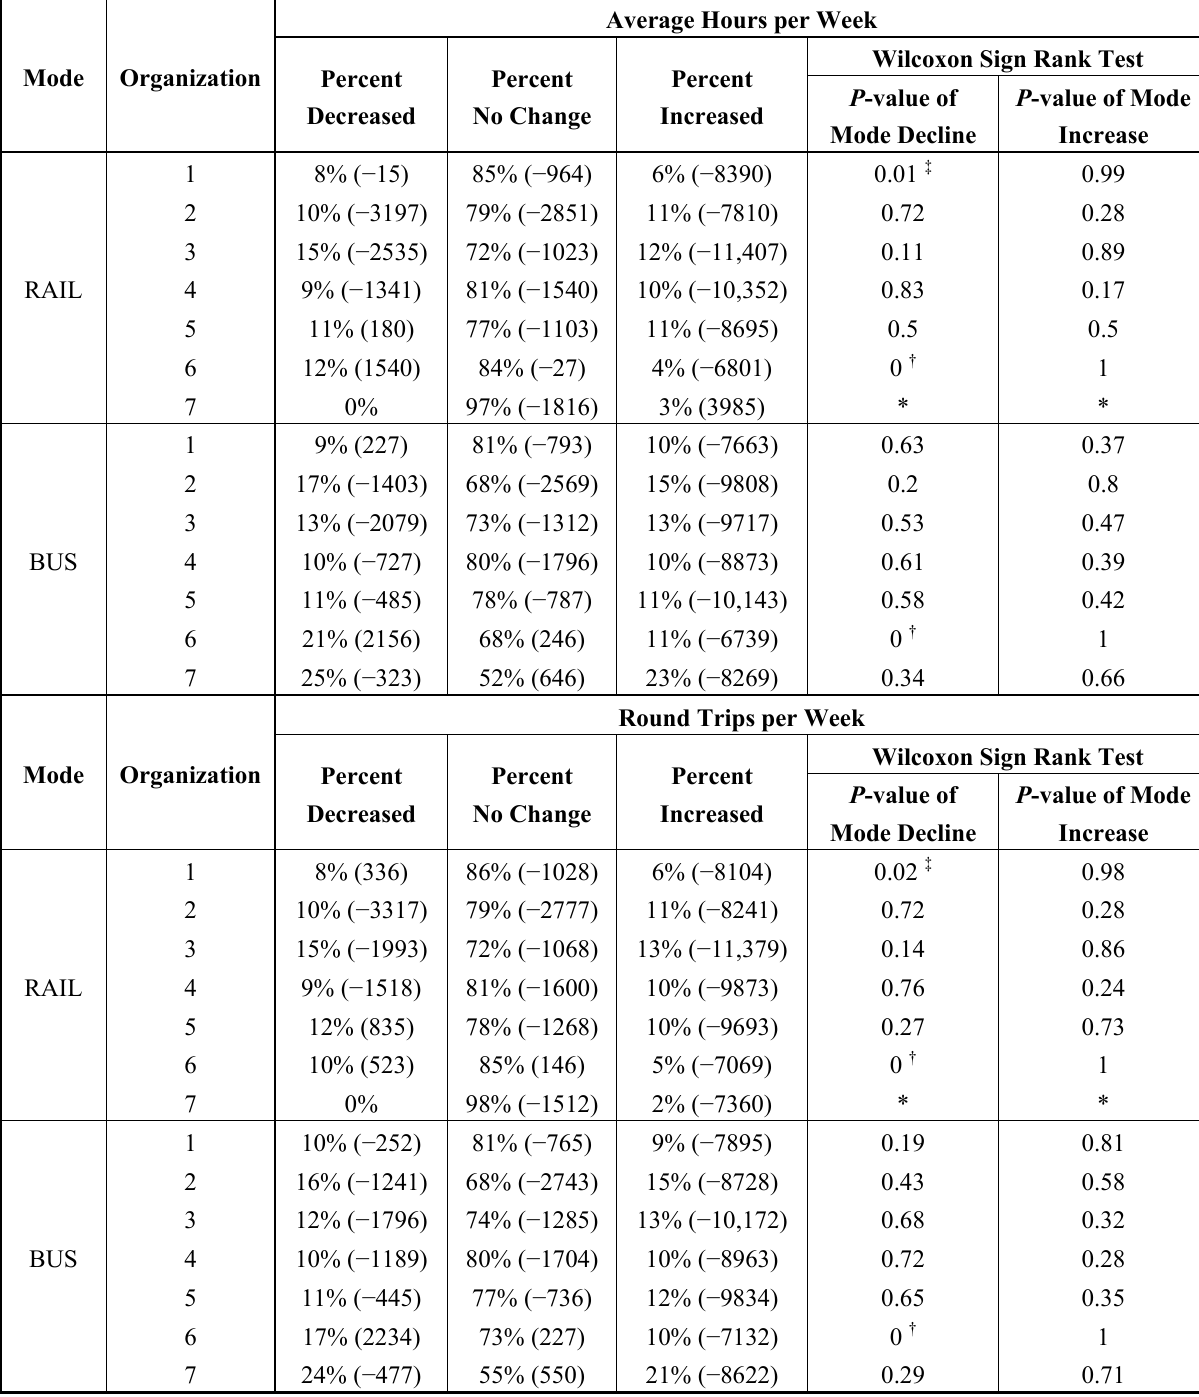
Table 3. Shift in Public Transit Use by Seven Largest North American Carsharing